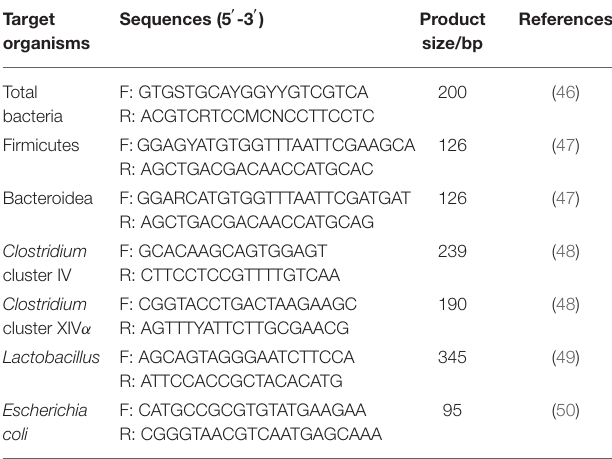
TABLE 2 | Primers used for bacterial count real-time